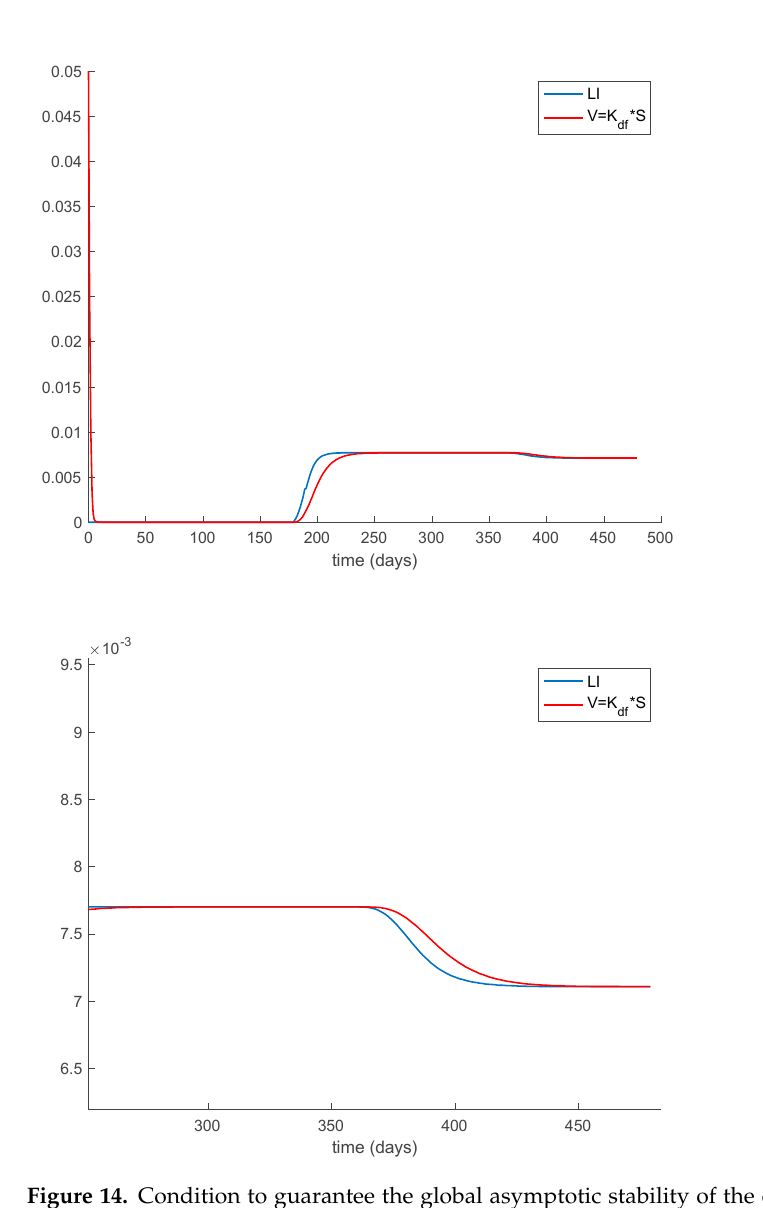
Figure 13. Vaccination action for Case 1.7 conditions.